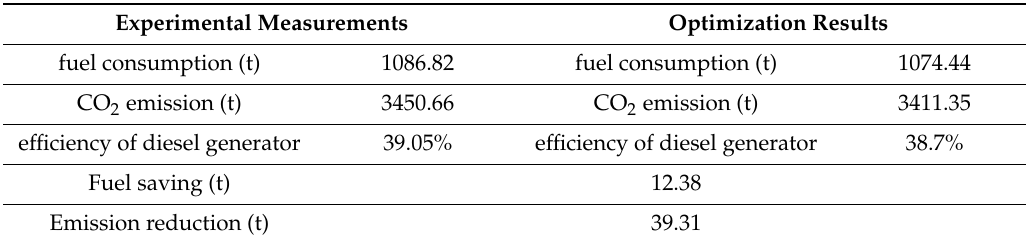
Table 4. The e ff ect on energy saving and reducing emission when the PSO algorithm method is used for one